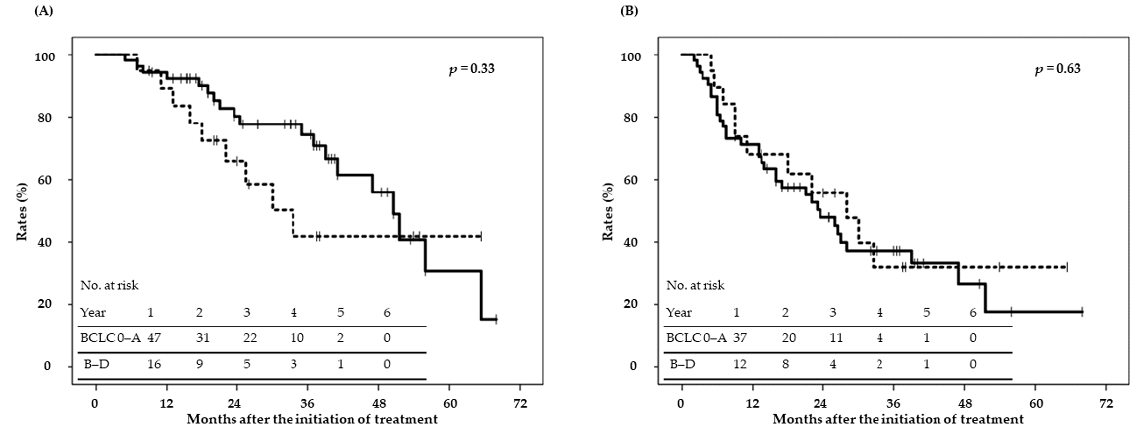
Figure 3. ( A ) OS and ( B ) PFS according to BCLC stage. Solid line, BCLC 0–A; dotted line, B–D. Table 4. Uni- and multivariate Cox’s analyses for local control.